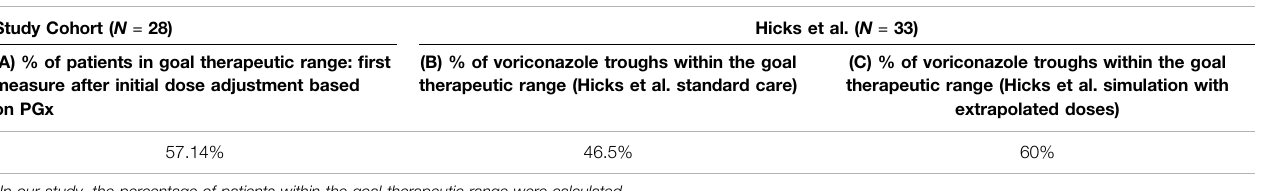
a In our study, the percentage of patients within the goal therapeutic range were calculated. b Hicksetal.calculatedtheproportionofvoriconazoletroughswithinthetherapeuticrange.TheproportionofpatientswithinthegoaltherapeuticrangecouldnotbeextractedfromHicks et al. ’ s